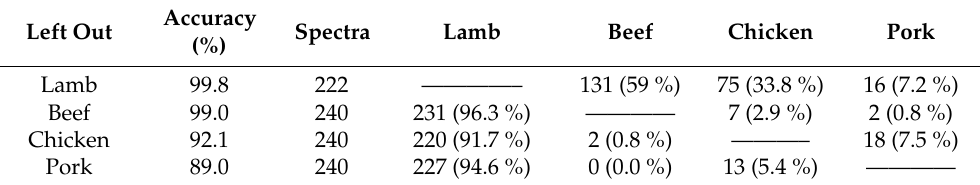
Table 6. SVM classification performance in leave-class-out validation. Accuracy values (column 2) are based on five-fold cross-validation of the remaining three class data (ground meat samples) for the Vis-NIR sensor.